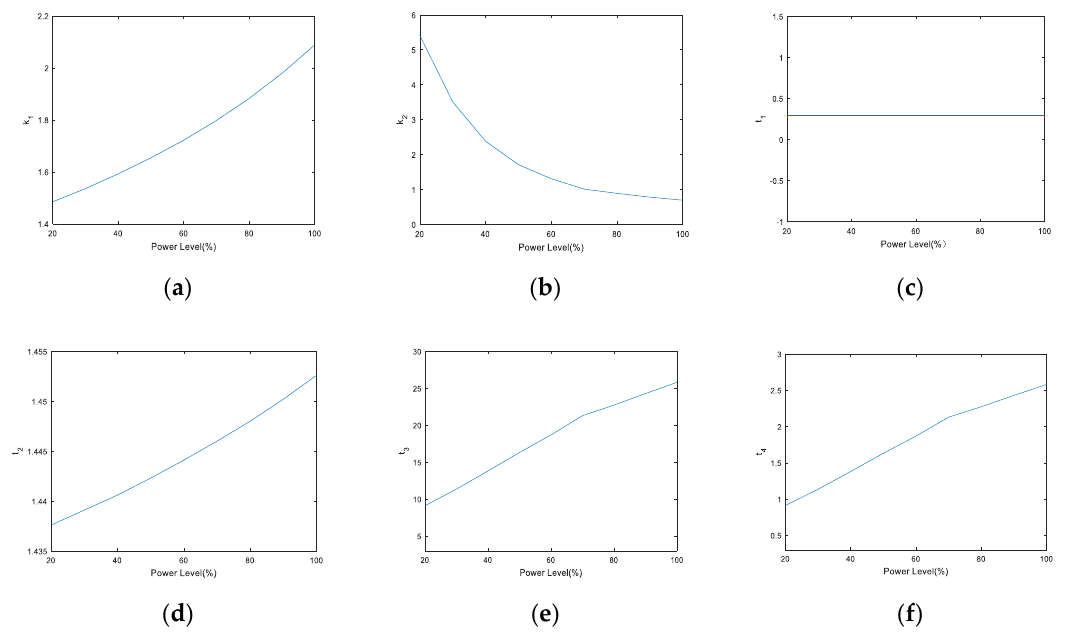
t , k , k , t , 2 1 2 1